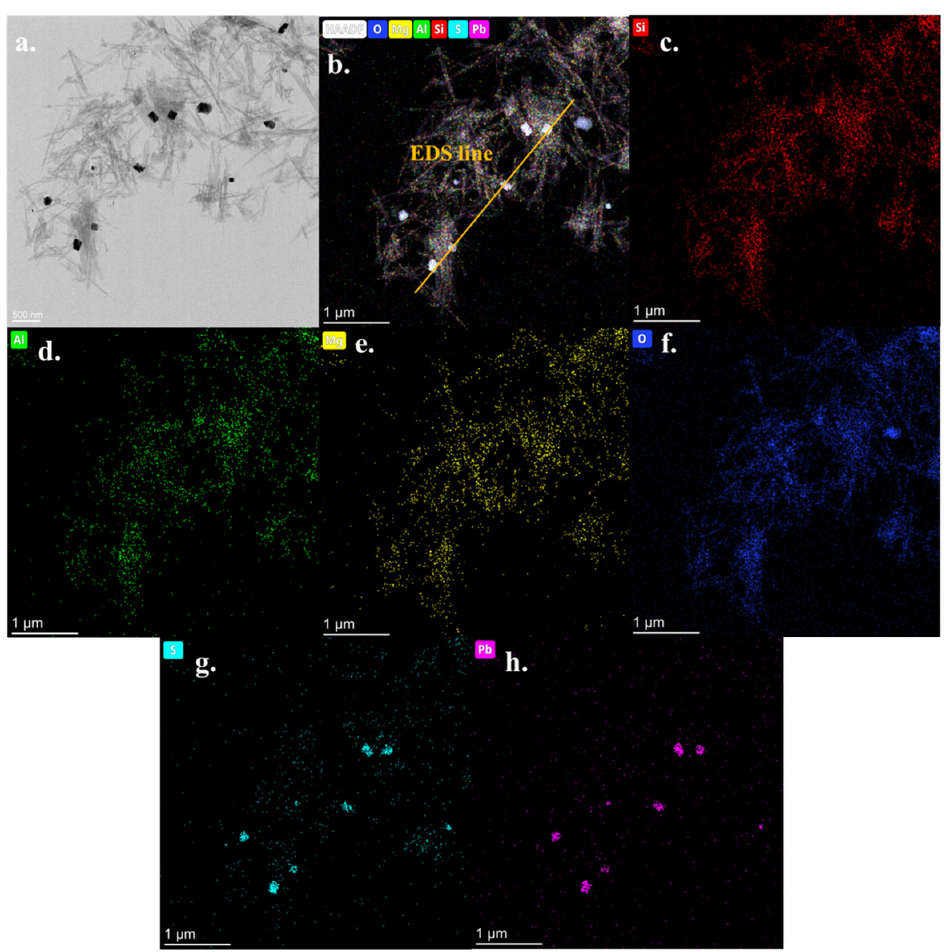
Figure 6. TEM (Transmission Electron Microscope)and HAADF (High-Angle Annular Field) results of AT@PbS (attapulgite/lead sulphide composite), element mapping results of ( a ) total elements, ( b ) Si, ( c ) Al, ( d ) Mg, ( e ) Mg, ( f ) O, ( g ) S, ( h ) Pb.